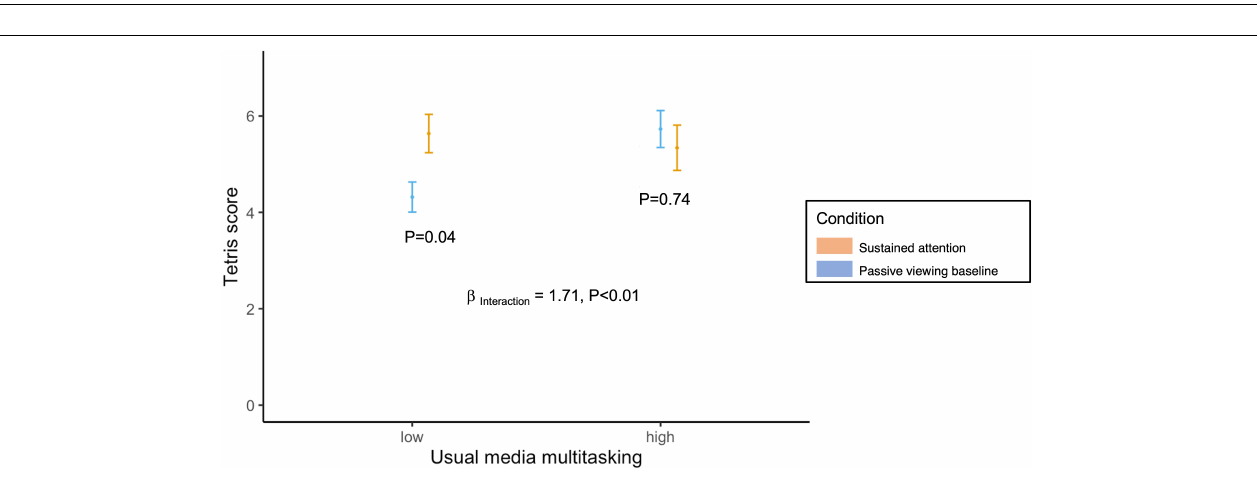
FIGURE 2 | Eye tracking metrics of attention to distractor images while playing Tetris following completion of the sustained attention and passive viewing baseline conditions. Data stratified by usual median multitasking and presented as mean ± 1.96 × SEM. P Interaction : Mixed effect model, nested within participant, predicting first fixation duration or cumulative fixation duration from condition coded as binary (0 = control; 1 = sustained attention), usual media multitasking coded as continuous and a multiplicative interaction between the two.